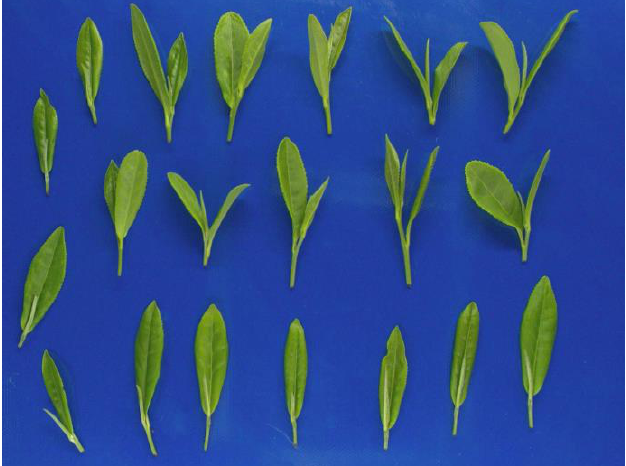
Figure 2. Appearance of the fresh tea